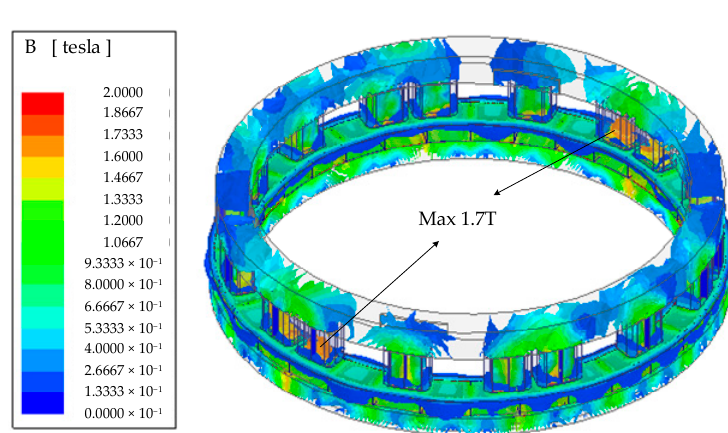
Figure 13. Flux density distribution of the 3D-FEM in on-load condition. Table 4. Parameter comparison of one unit tooth structure.